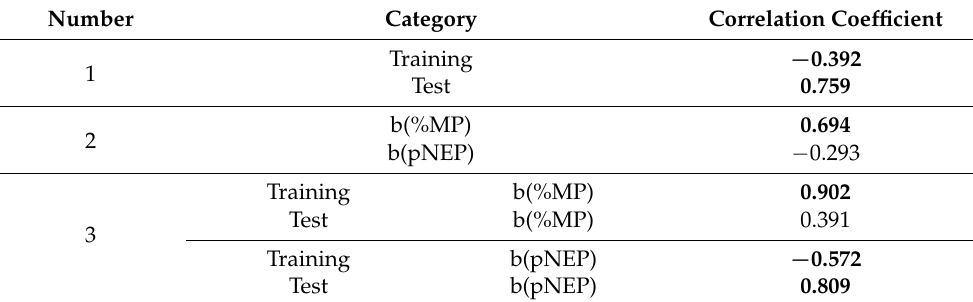
Table 4. The values of linear correlation coefficients for neural network assessment indicators (%MP and pNEP).